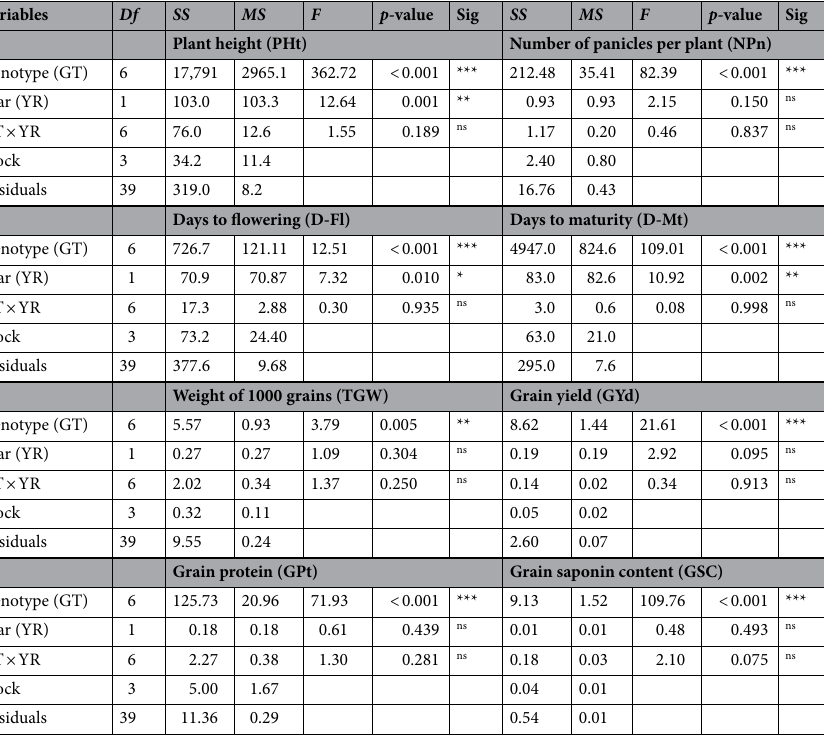
Table 3. ANOVAs for RCBD testing the variation of growth, yield and grain-quality parameters and precocity indicators of quinoa following genotypes and years in the Sahara Desert of Algeria. Df : degrees of freedom, SS : sum squares, MS : mean squares, F : F -statistics, Sig .: statistical significance, ***: p < 0.001, **: p < 0.01, *: p < 0.05, ns : p >